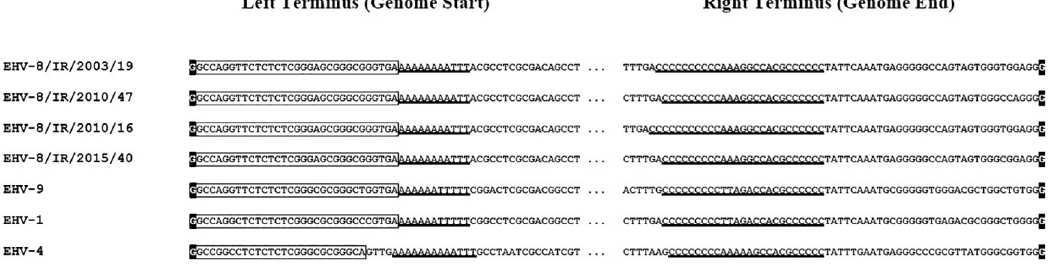
Fig 3. Conserved sequences near the genome termini of equid varicelloviruses. An alignment of sequences from the four Irish equid herpesvirus (EHV) 8 (EHV-8) strains, EHV-9 P19 (AP010838.1), EHV-1 AB4 (AY665713.1) and EHV-4 NS80567 (AF030027.1) is shown. In each sequence, TR L is boxed, the terminal nucleotides are shaded black, and conserved regions AnTn and γ (which are present near the left and right termini, respectively) are underlined. Ellipses denote the remainder of the